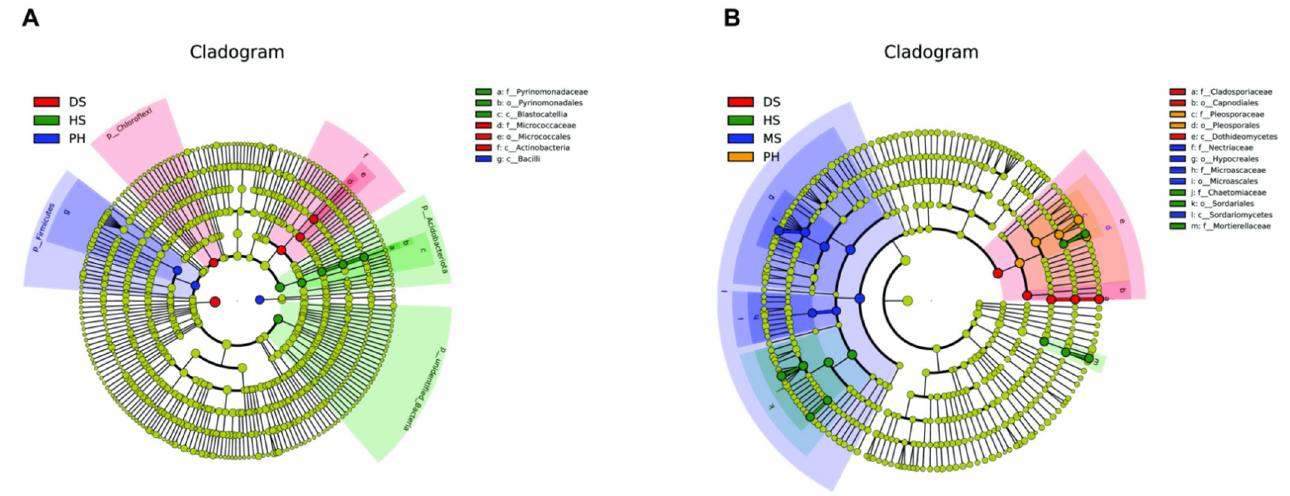
Figure 6. Linear discriminant analysis effect size (LEFSE) was employed based on the 10 compart- ments of data to identify the bacterial ( A ) and fungal ( B ) community biomarkers.